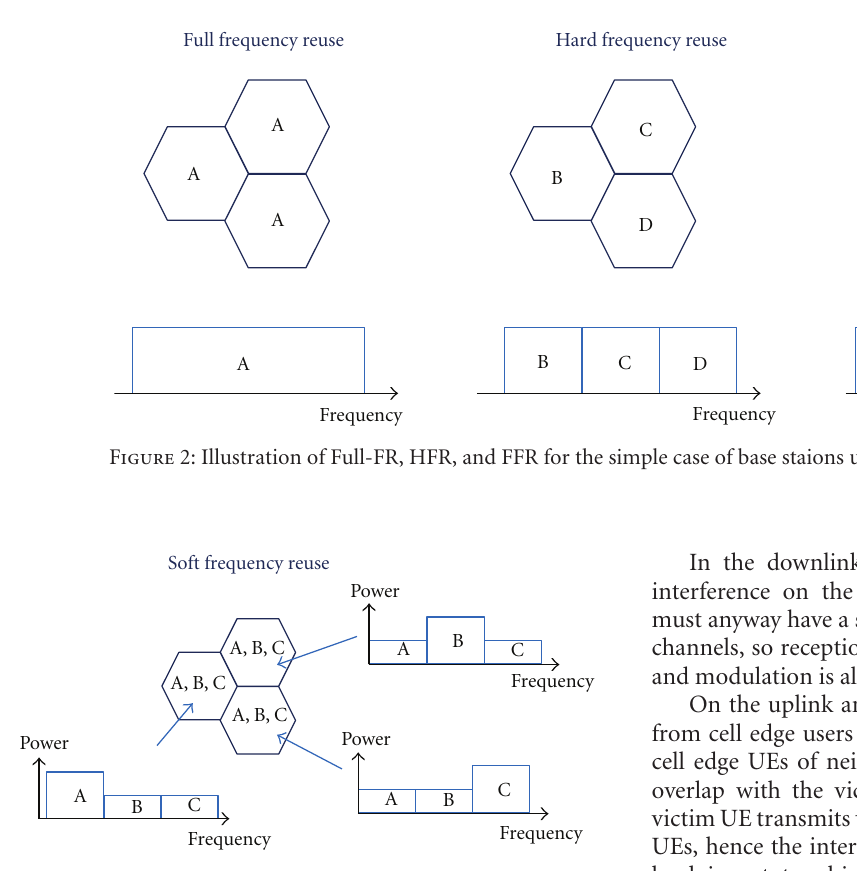
Figure 3: Example of soft frequency